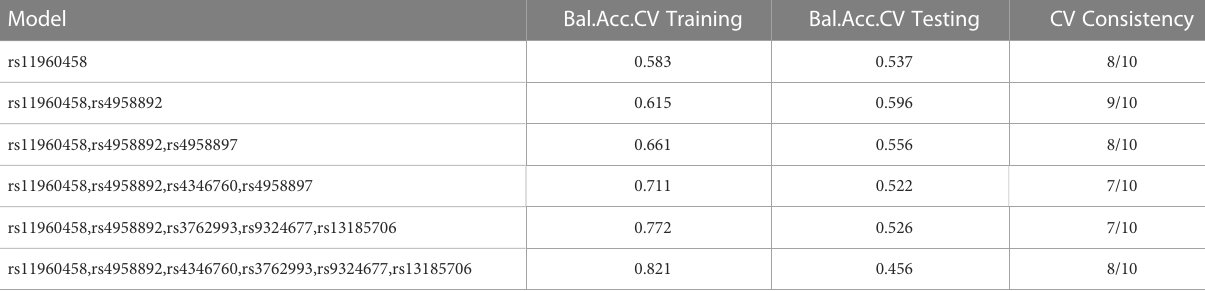
TABLE 6 The SNP-SNP interactions analysis.